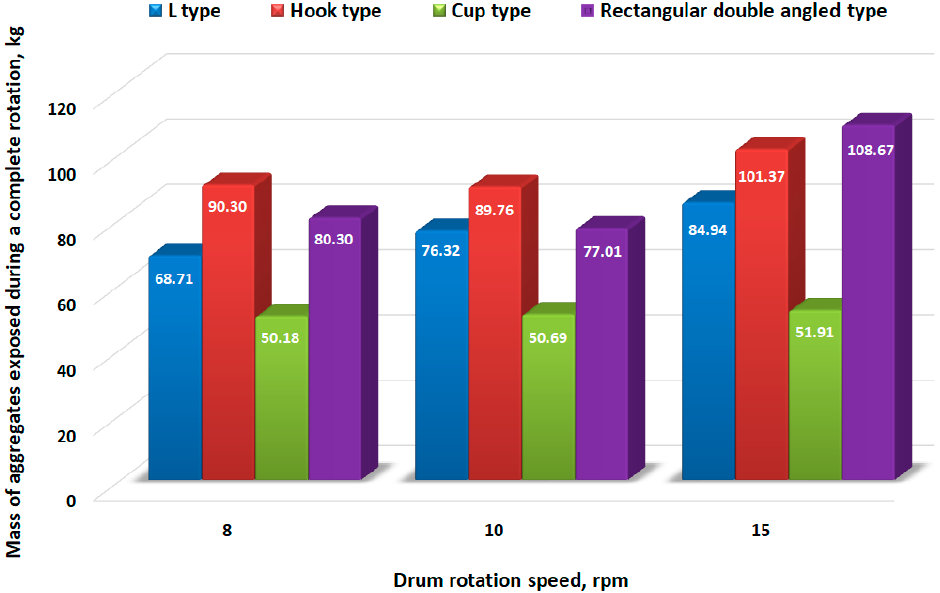
Figure 8. The influence of flight shape on the mass of aggregates exposed to drying during a com- plete rotation for 20% drum filling degree. rotation for 20% drum filling